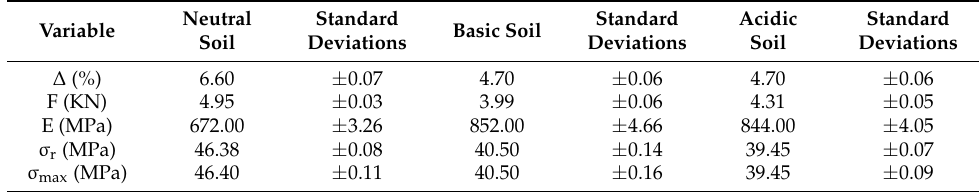
Table 6. Mean values of axial tension.